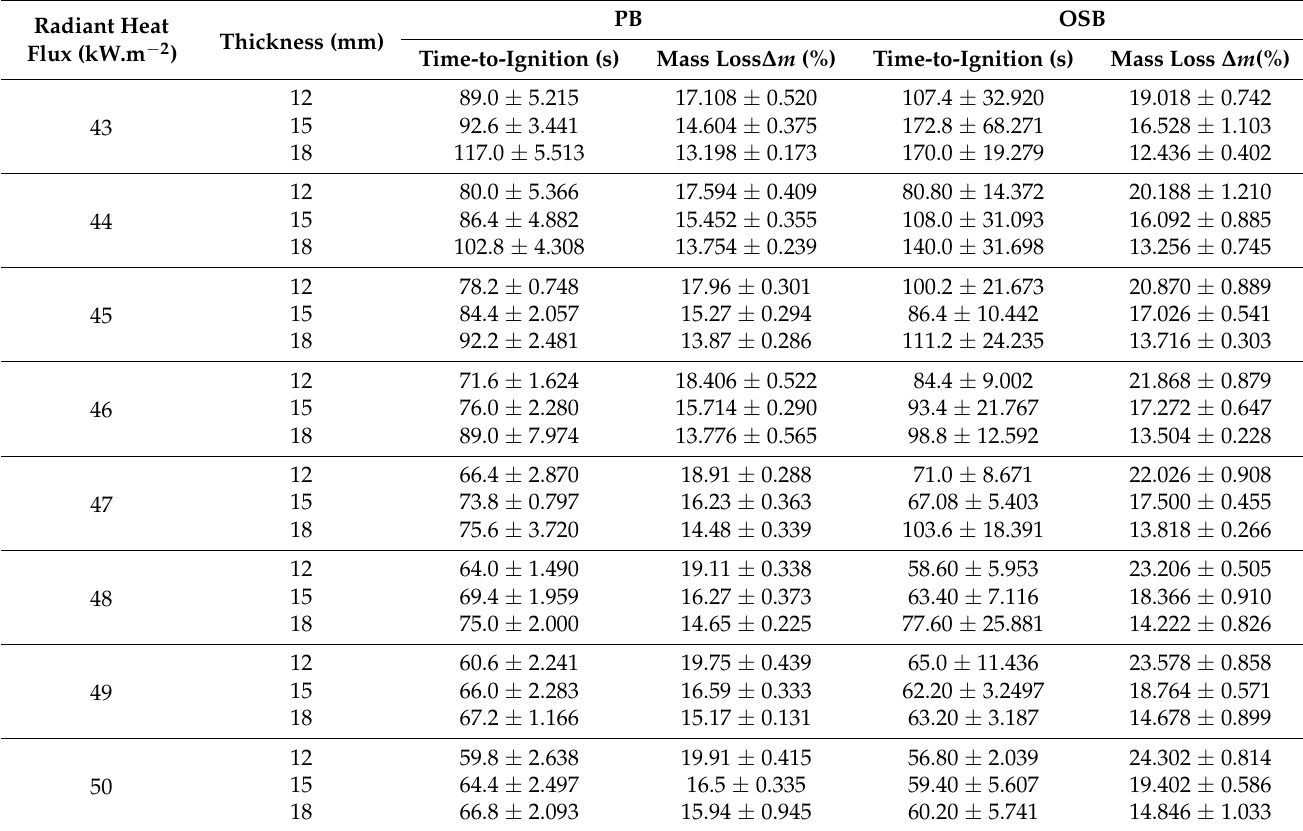
Table 3. Time-to-ignition and mass loss of samples with different thicknesses using heat fluxes from 43 to 50 kW.m − 2 at a distance of 20